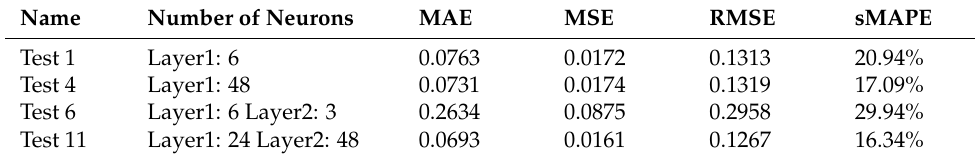
Table 6. Adam algorithm final test